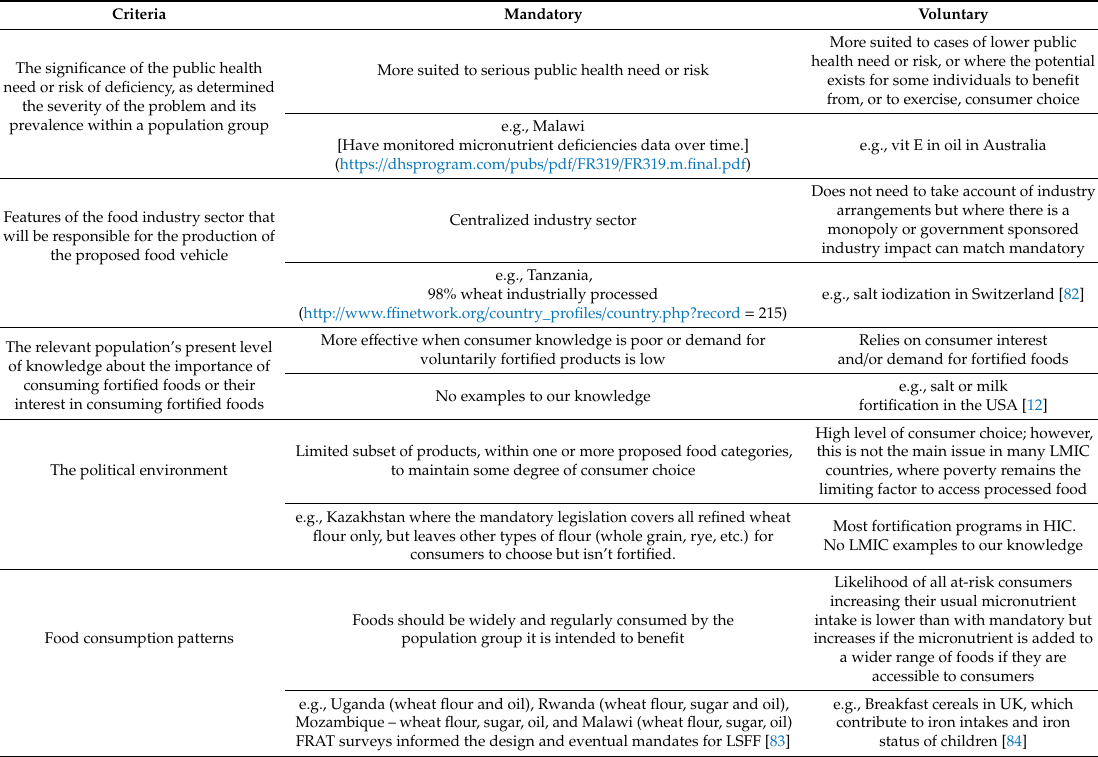
Table A1. Criteria governing the selection of mandatory or voluntary fortification with country examples (adapted, WHO / FAO guidelines [24] Section